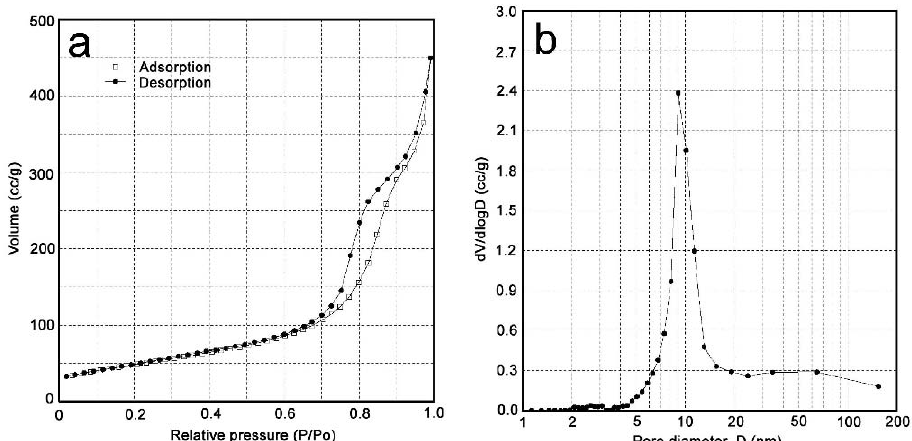
Fig. 4 (a) N adsorption/desorption isotherms and (b) BJH plot for desorption showing 2 pore-size distribution for the partially nanowire-structured TiO 6.01 %, respectively.